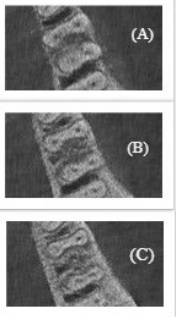
Figure 5. Changed cross-sectional root canal shape for mandibular first molar from ribbon shape type I in the coronal third to ribbon type 5 in the apical third for mesial root. (( A ): refers to coronal third, ( B ): middle third, ( C ): apical third of root canal).